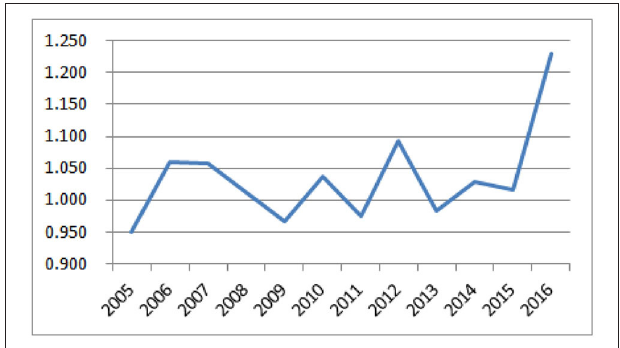
FIGURE 3 | Dynamic efficiency trend of green transformation in western resource-based cities from 2005 to 2016.